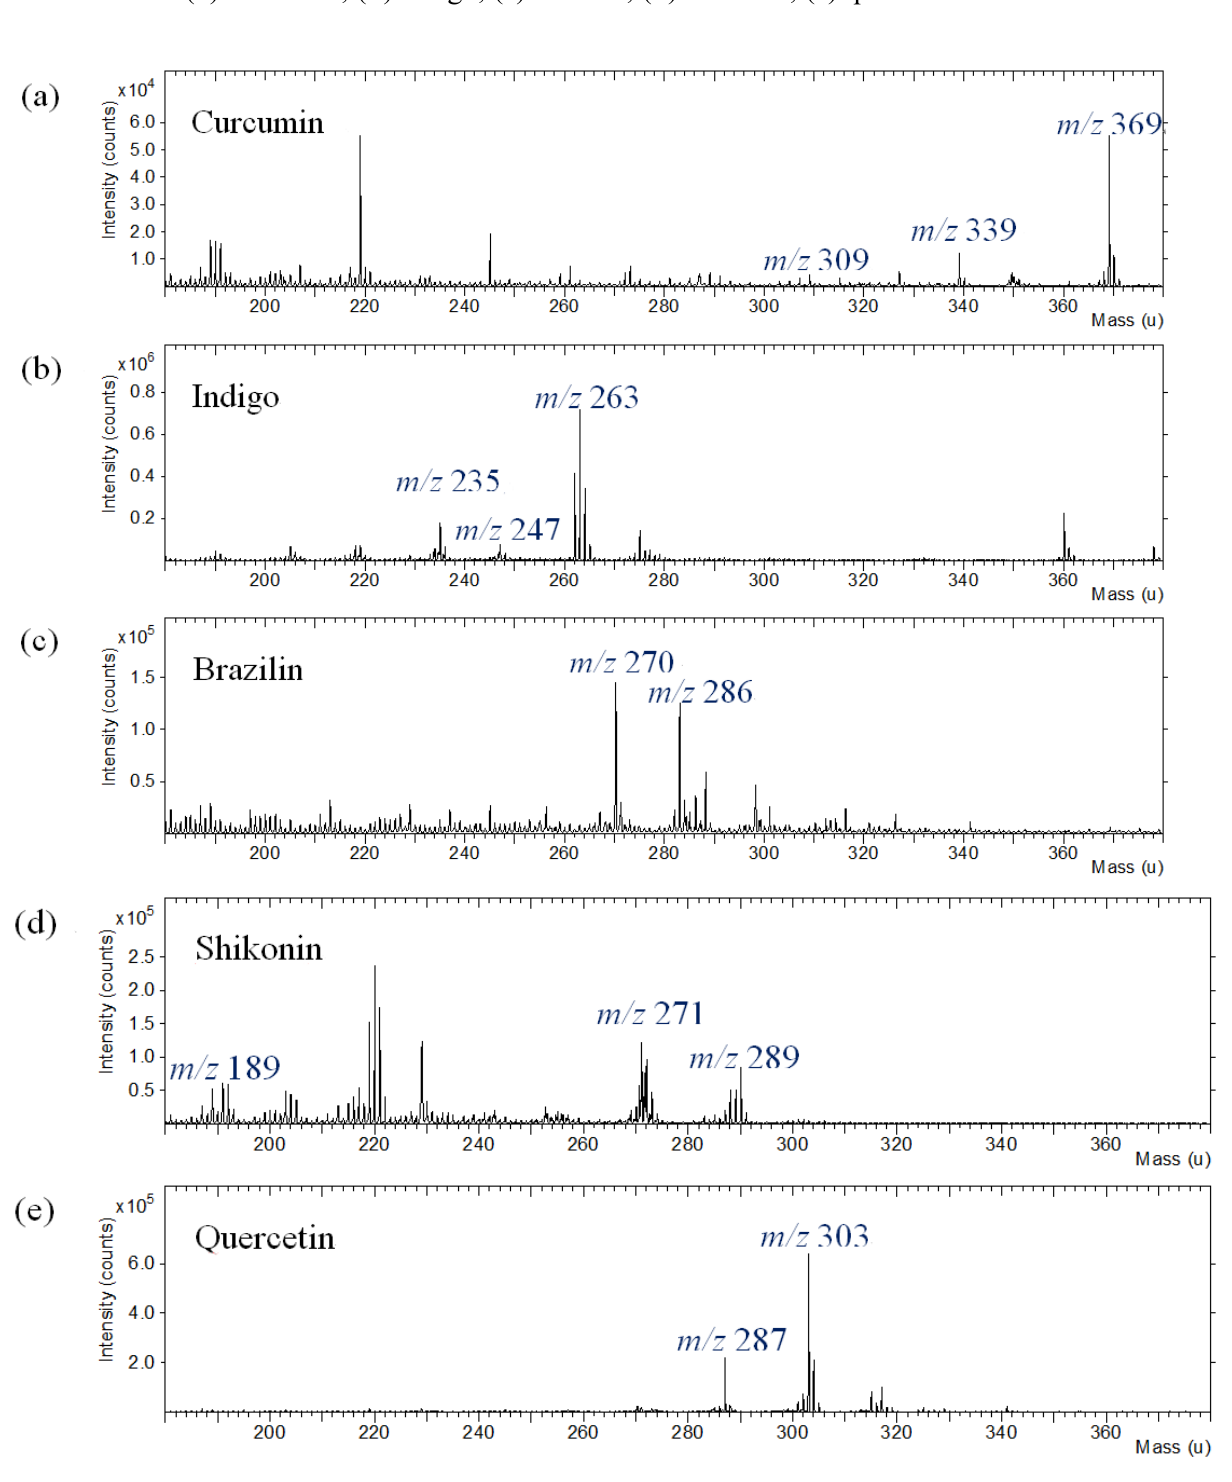
Figure 5. Positive ion TOF-SIMS spectra of commercial natural dyes on the silicon substrate. ( a ) curcumin; ( b ) indigo; ( c ) brazilin; ( d ) shikonin; ( e )